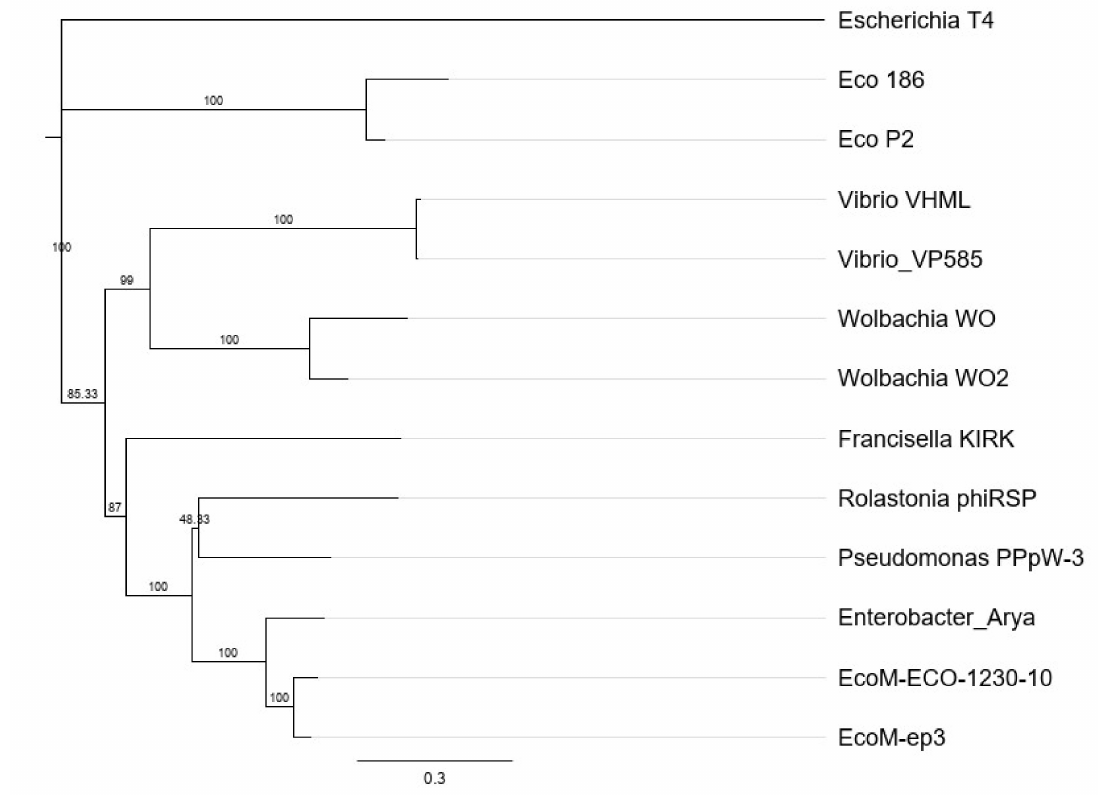
Figure 3. Phylogenetic tree analysis of the bacteriophage KIRK. 7 loci concatenated protein sequence of genes fhv_0018, 0024, 0012, 0008, 0025, 0028, 0023 ) and available homologous proteins from bacteriophages Escherichia T4 ( Tevenvirinae , AF158101), Escherichia 186 ( Peduovirinae , NC_001317), Escherichia P2 ( Peduovirinae , KC618326), Vibrio VHML ( Vhmlvirus , NC_004456), Vibrio VP585 ( Vhmlvirus , NC_027981), Wolbachia WO2 (MK976036), Wolbachia WO (MN180249), Ralstonia phiRSP ( Jilinvirus , MH252365), Pseudomonas PPpW3 ( Jilinvirus , NC_023006), Enterobacter Arya ( Jilinvirus , NC_031048), Escherichia ECO-1230-10 ( Jilinvirus , GU903191) and Escherichia EcoM-ep3 ( Jilinvirus , NC_025430) were used for amino acid sequences alignment using the ClustalO program in Geneious. The phylogenetic tree was generated by using Geneious Tree Builder, Neighbor-Joining method and Escherichia T4 phage as